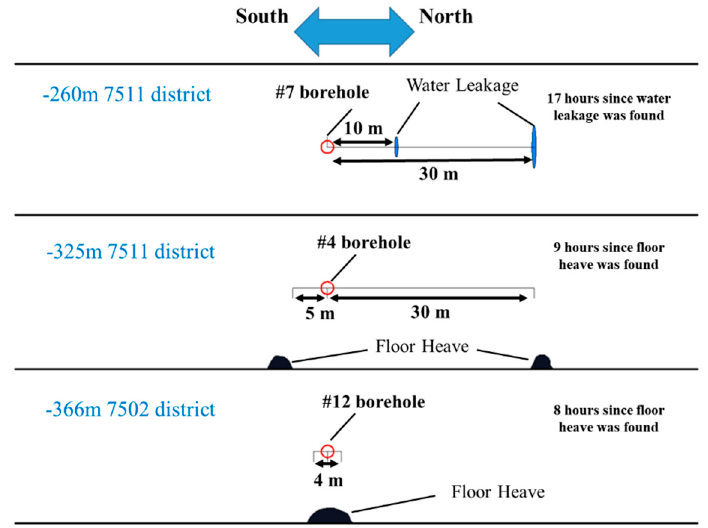
Figure 7. Variation of surrounding rocks in the three districts.